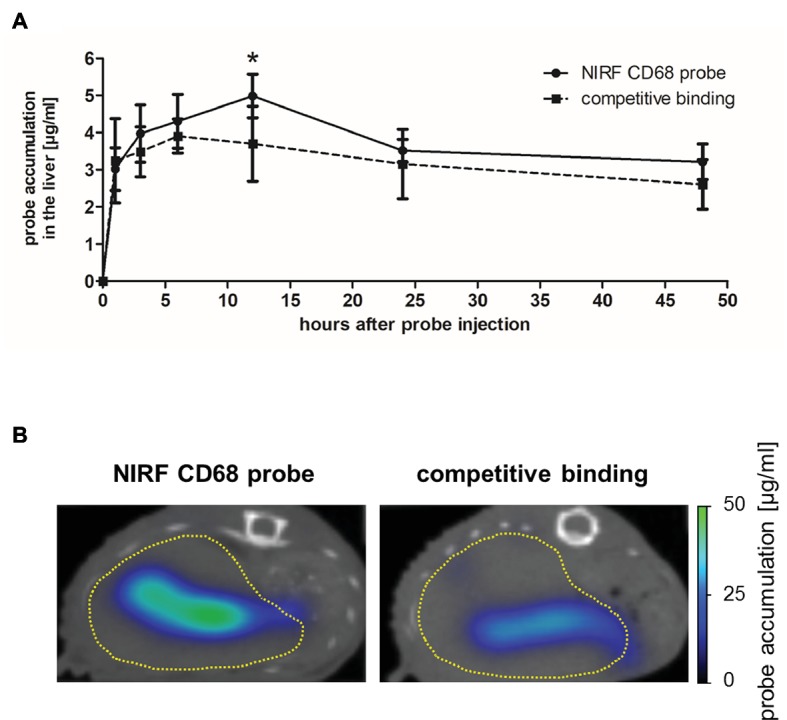
In vivo specificity of the NIRF CD68 probe. To analyze the in vivo specificity of the NIRF CD68 probe, a competitive binding experiment was performed in which a 5-fold excess of unlabeled CD68 antibody was injected 1 h prior to the injection of the NIRF CD68 probe (competitive binding group). Probe accumulation in the liver was compared to the concentration measured after injection of the NIRF CD68 probe alone (control group). (A) Quantitative analysis of probe accumulation in the liver showed a significant difference in the mean concentration 12 h after injection (*p < 0.05; data are presented as mean values ± SD). (B) Transversal FMT-μCT fusion images of representative mice 12 h after injection show a high fluorescent signal in the liver of the control mouse and a strongly reduced signal in the liver as a result of competitive binding (dashed yellow line indicates the liver).